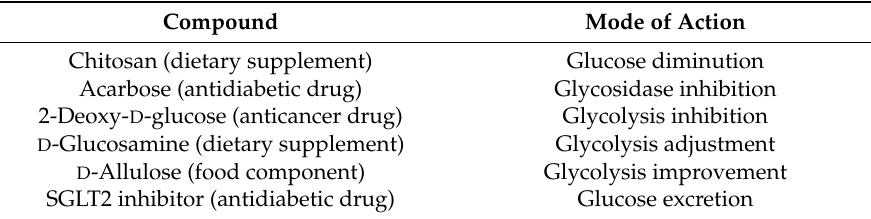
Table 2. Upstream-type